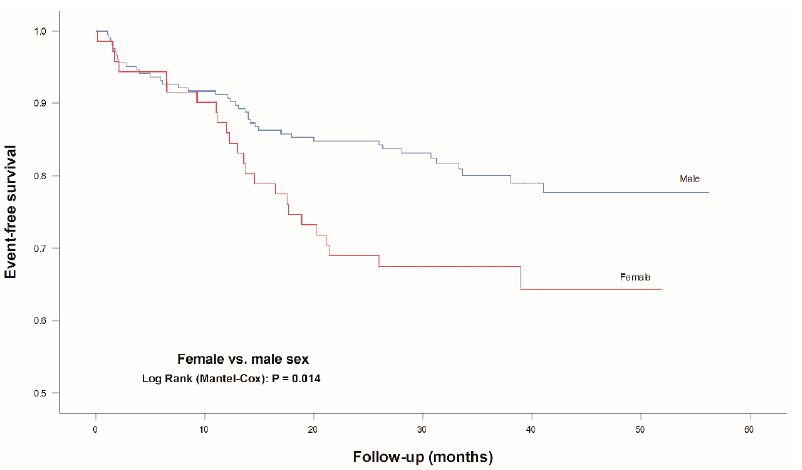
Figure 2. Hazard ratios (HR) of MACCE for different predictors: ( A ) Unadjusted rates; ( B ) Adjusted rates. * Multivariate Cox regression model-reference groups for categorical variables: male sex; no diabetes mellitus. Legend: MACCE, major adverse cardiovascular and cerebrovascular events (com- posite of cardiac mortality, ischemic stroke, urgent coronary revascularization and nonfatal myo- cardial infarction); LVEF, left ventricular ejection fraction; eGFR, estimated glomerular filtration rate; BMI, body mass index; RBC, red blood cells.